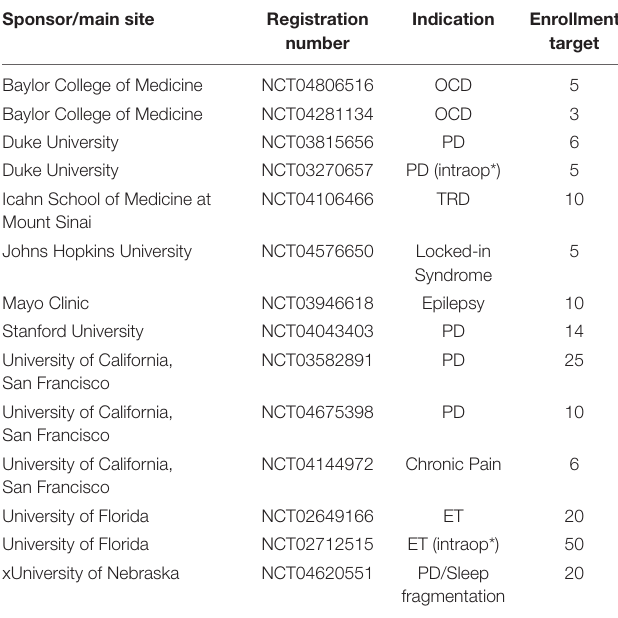
TABLE 1 | Clinical trials using the Medtronic Summit RC + S system.